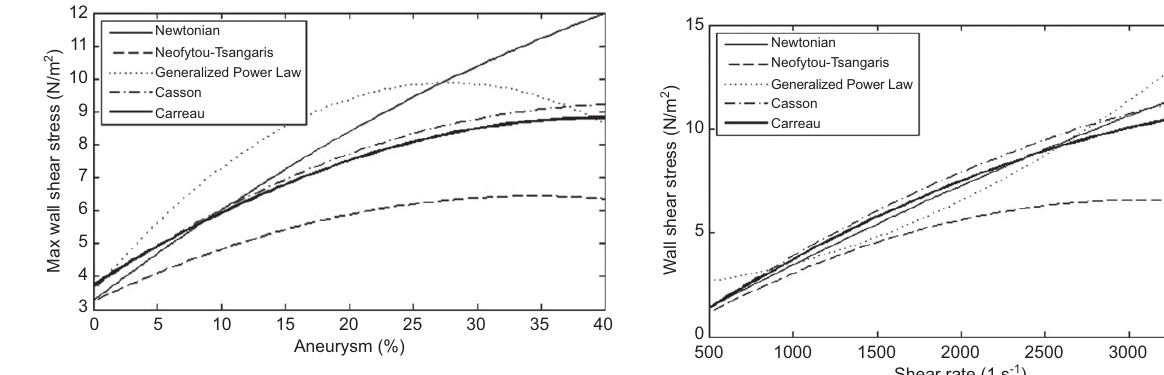
Figure 6 WSS vs. shear rate in an